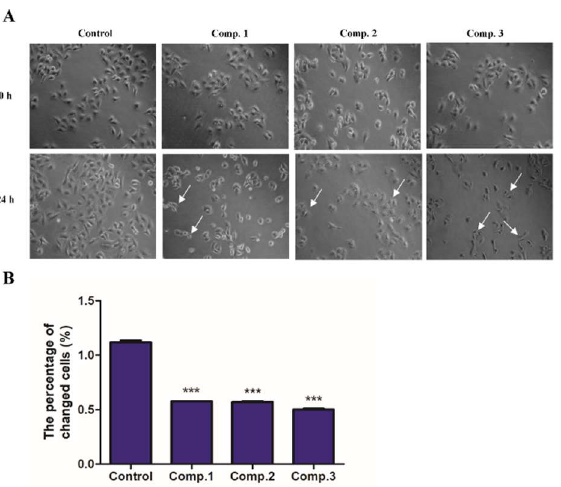
Figure 6. Morphological changes of A549 cells. ( A ) The cell lines were exposed to equimolar (3 μM) concentration of compounds 1-3 , following 24 h treatment, versus control group (untreated cells). Scale bars, 50 μm. White arrows show the apoptosis cells. ( B ) Quantitative analysis of live cells. Data are expressed as means from three independent experiments. *** p < 0.001 vs the 0 h group.